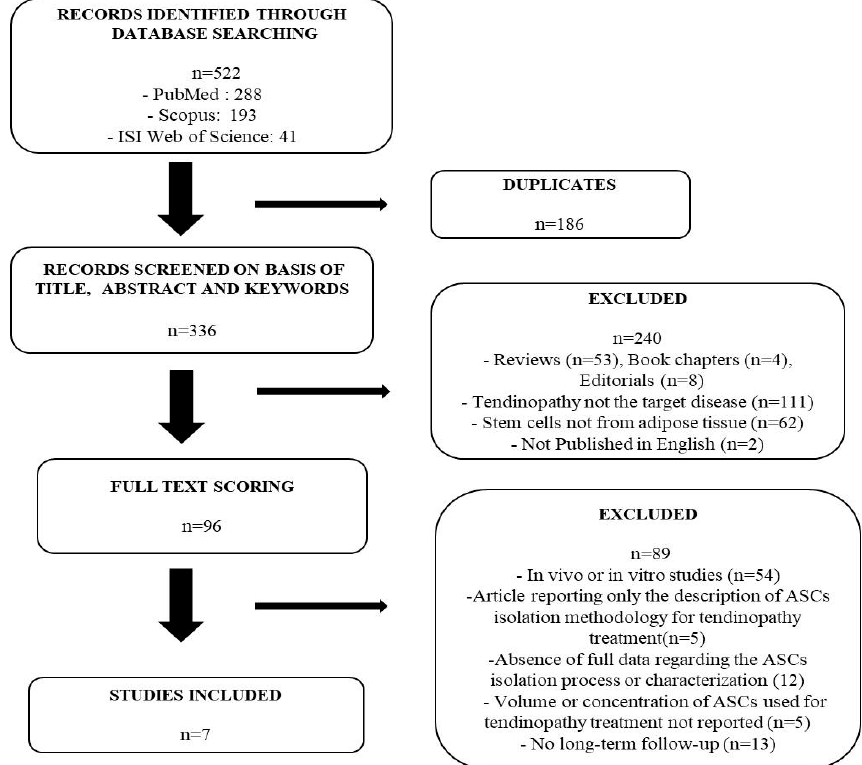
Figure 1. Flowchart diagram of the study selection process for this systematic review.